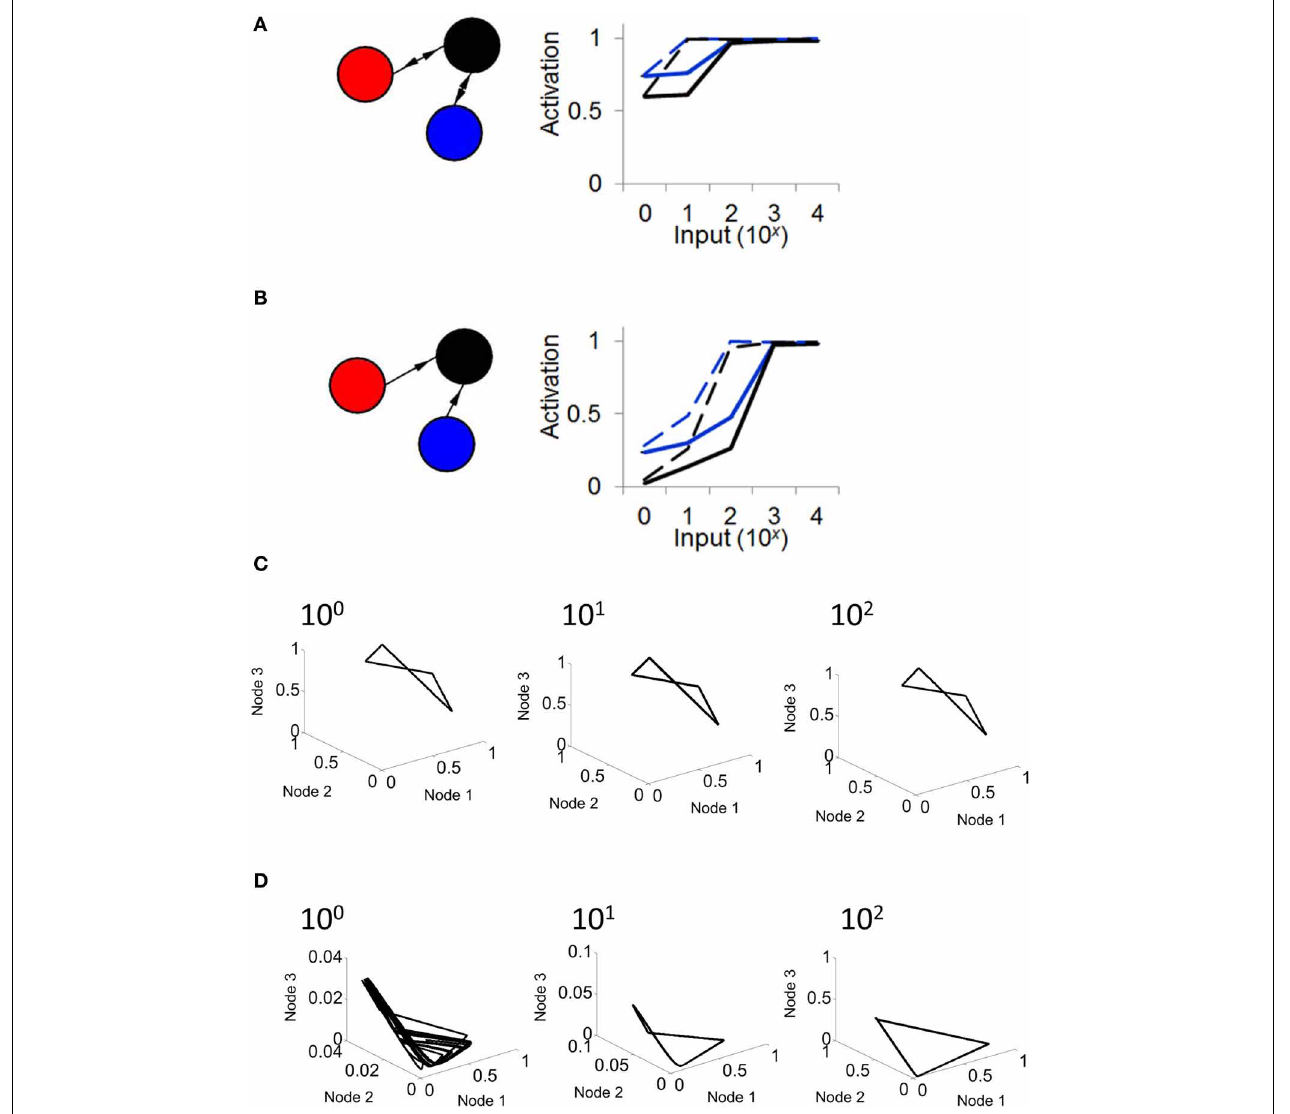
lines, weights of w = 100. ( B ; left) Network with strictly feedforward connections. (right) In a feedforward network, mean activity increases in responsetoinput,anddoesnotsaturateuntilthestrengthofinputreaches10 3 . (C) In a relay network, activity follows a limit cycle regardless of the strength of input. (D) In a feedforward network, activity follows a limit cycle for stronger input (10 2 ) but not for weaker input (10 0